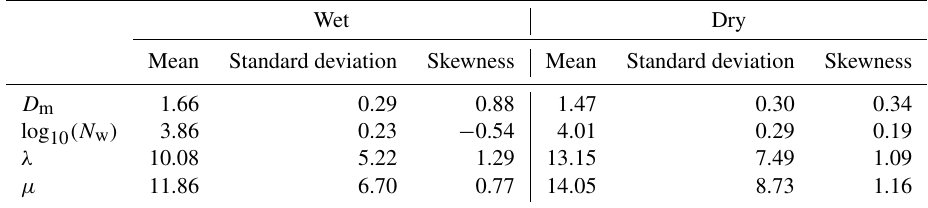
Table 4. Mean, standard deviation, and skewness of the DSD parameters in convective rain for wet and dry spells. Wet Dry Mean Standard deviation Skewness